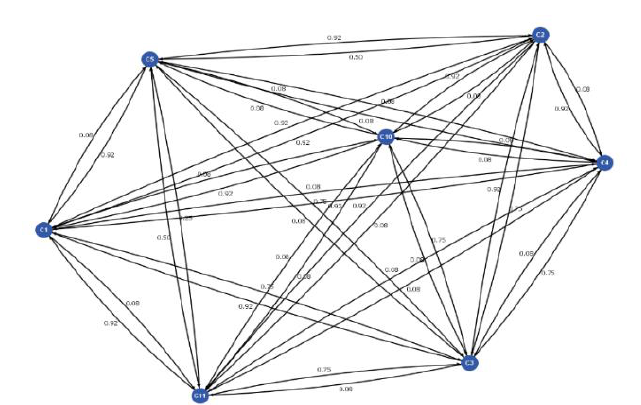
Fig. 3. Graphical representation of P&S factors of